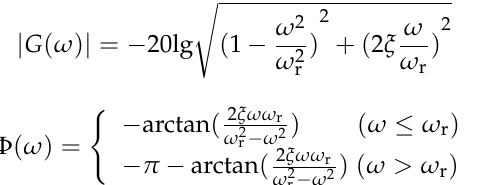
ω ω . Figure 3 provides the 3D graph of the frequency characteristic.